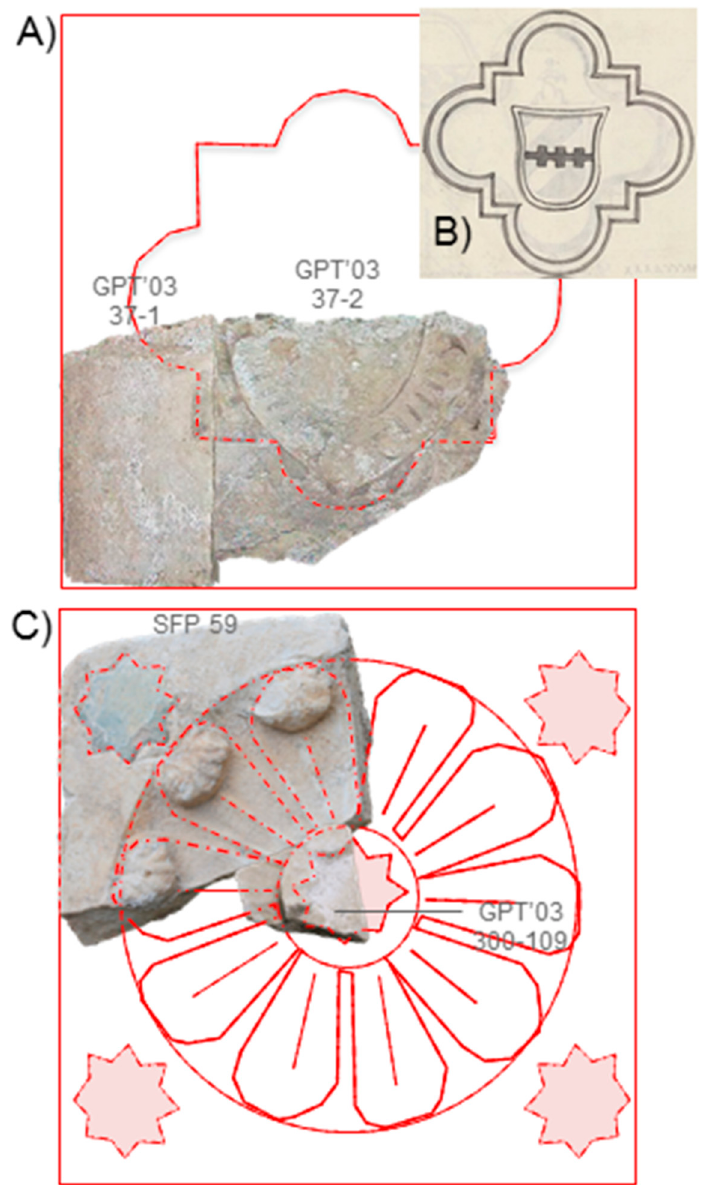
Figure 4. Reconstruction of sculpted tiles. ( A ) Entombment sculpted tile reconstructed joining the two fragments GPT’03 37-1 and GPT’03 37-2. The photography of the fragments is courtesy of the Superintendence of Archaeology, Fine Arts and Landscape for the metropolitan city of Genoa and the provinces of Imperia, La Spezia and Savona (partial or total reproduction is forbidden without prior (written) permission). ( B ) One of the drawings of the manuscript Epitaphia, sepulcra et inscriptiones cum stemmatibus marmorea et lapidea existentia in ecclesis genuensibus , by Domenico Piaggio, with an aspect similar to tile a), folio 36. Photographic reproduction courtesy of the Berio Library, Genoa. ( C ) Floral sculpted tile with inlays resulting from the merging of the two fragments GPT’03 300-109 and SFP 59. The photography of the fragments is courtesy of the Superintendence of Archaeology, Fine Arts and Landscape for the metropolitan city of Genoa and the provinces of Imperia, La Spezia and Savona (partial or total reproduction is forbidden without prior (written) permission).